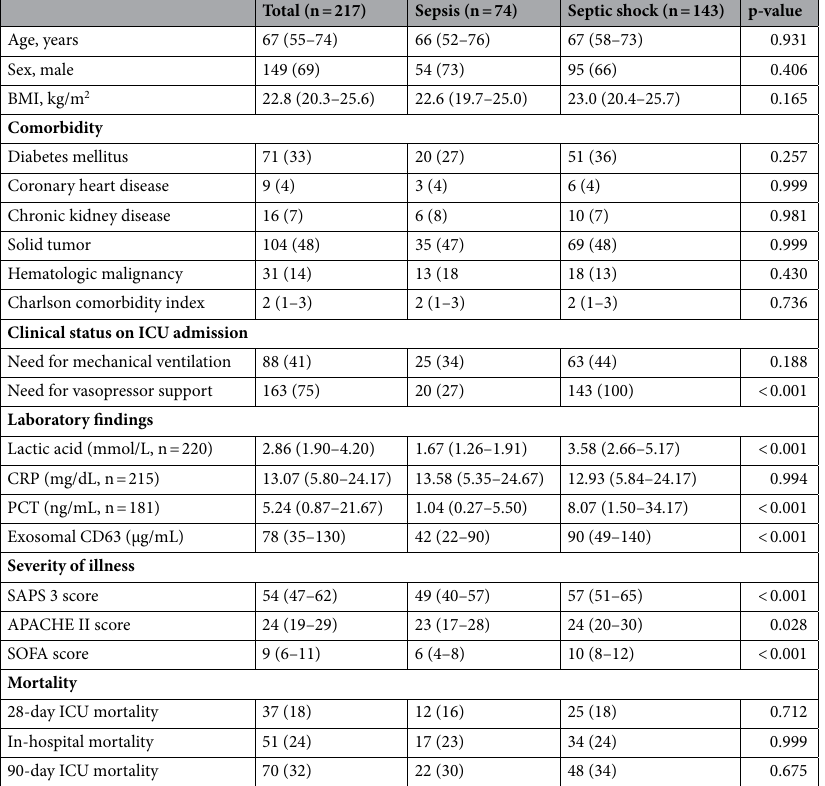
Table 1. Characteristics of study participants. Data are presented as medians (interquartile range) or numbers (%). BMI, body mass index; ICU, intensive care unit; CRP, C-reactive protein; PCT, procalcitonin; SAPS, simplified acute physiology score; APACHE, acute physiology and chronic health evaluation; SOFA, sequential organ failure